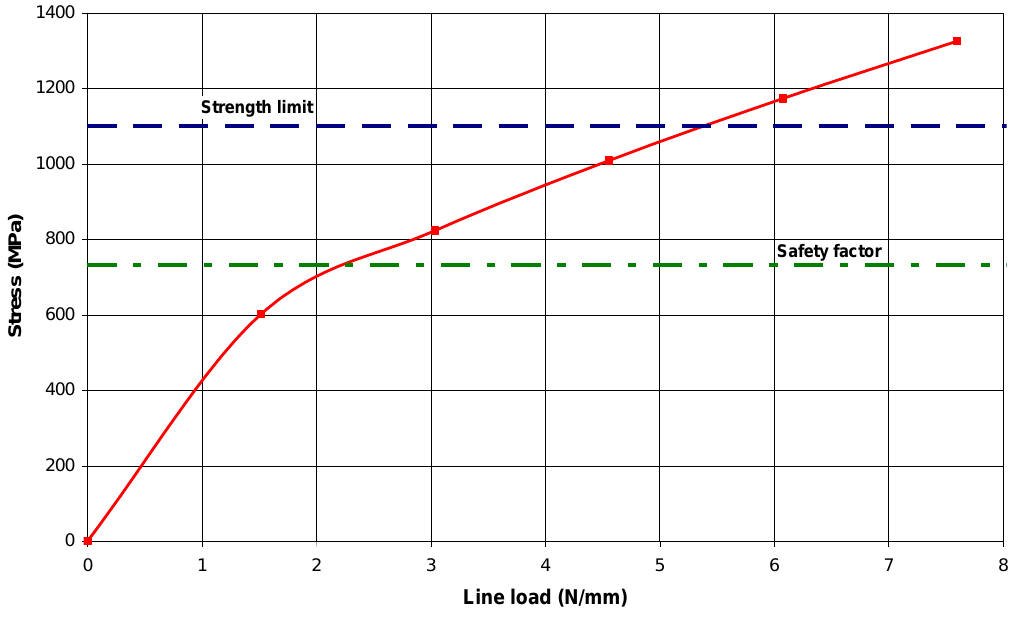
Figure 6. Relationship of maximal Von Mises stress in the optical fiber on an optical fiber line load with respect to a strength limit of 1,100 MPa and safety factor of